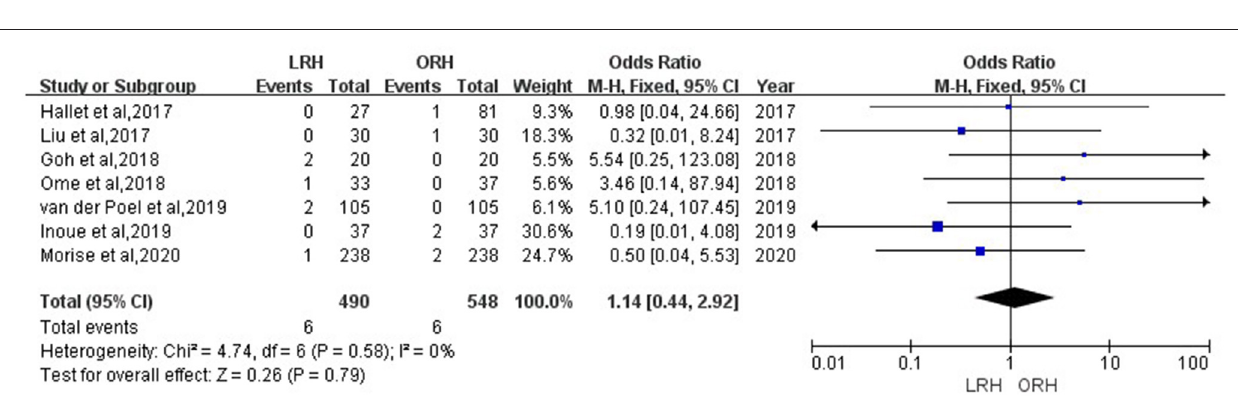
FIGURE 11 | Forest plots comparing mortality between LRH group and ORH